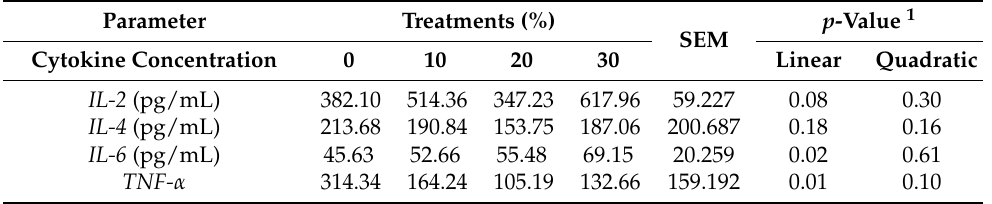
Table 7. Least square mean values for serum concentration of select cytokines on day 60 of feeding trial.